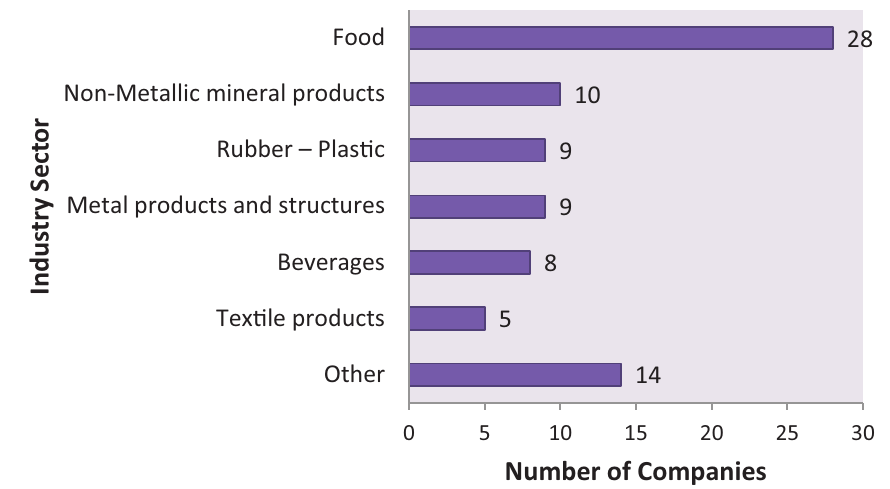
Figure 1. Profile of the companies: Industry sector.